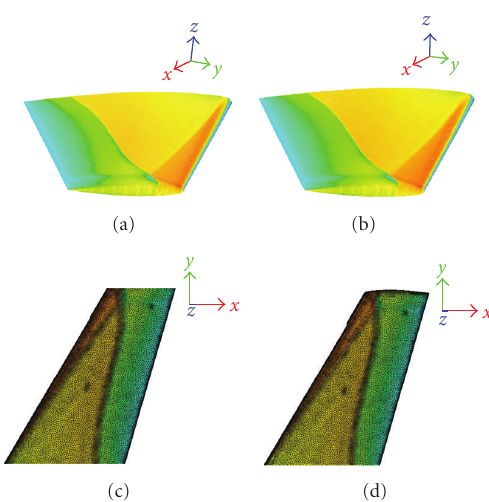
Figure 26: Solution ( M ∞ ) and grids on the ONERA M6 wing with (left) and without (right) projection.